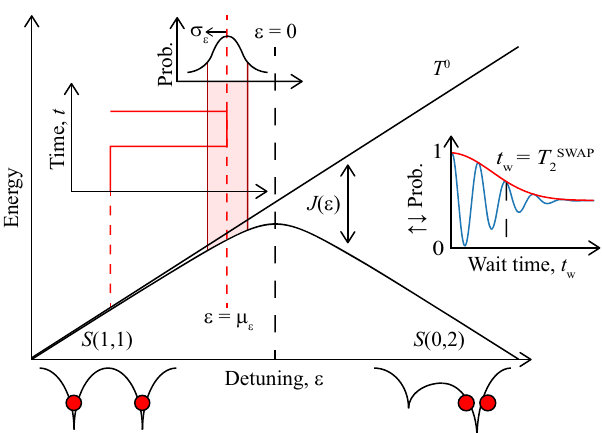
Fig. 1 Pulse scheme to observe coherent exchange oscillations in exchange-coupled atom qubits in silicon. Singlet (S(1,1) and S(0,2)) and triplet ( T 0 ) state eigenspectrum as a function of detuning ϵ for a two electron-spin, double-dot system that forms an anti-crossing centred around ϵ = 0. As the electrons (red dots) are pulsed from separate dots to the same dot, the exchange strength J ( ϵ ) increases. Using an appropriate gate pulse scheme (red line, upper left inset), coherent oscillations in the two-electron spin probabilities (e.g. ↑↓ ) can be measured (blue line in right inset) as a function of the wait time t w at the detuning position ϵ = μ ϵ . Here the "#j i probability oscillates up and down while decaying over time characterised by . Charge noise shifts the position of the the decoherence time T SWAP 2 detuning pulse around the intended detuning μ ϵ with a probability described by a Gaussian distribution of standard deviation σ ϵ (upper inset). The resultant distribution in exchange interaction frequencies which is the main factor that limits the decoherence time T SWAP 2 characterises the decay envelope (red line, right